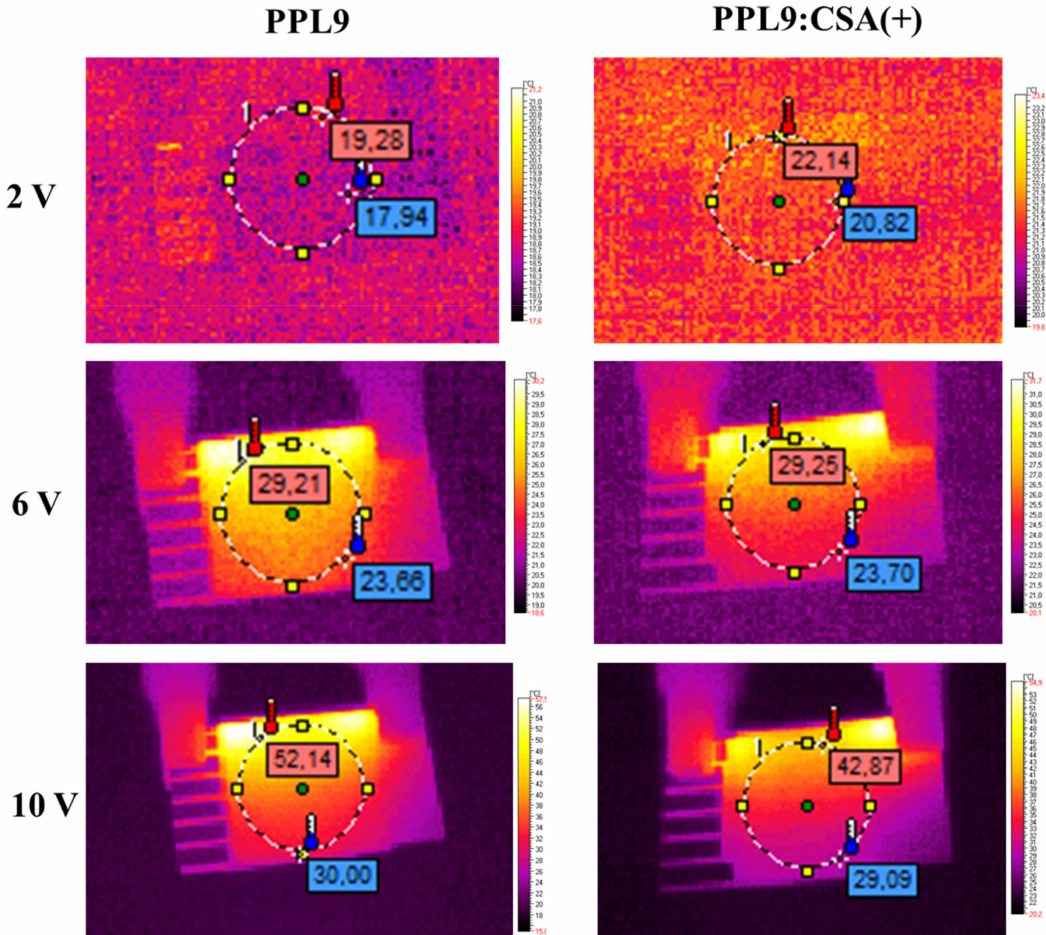
Figure 8. IR images obtained for constructed devices at 2 V, 6 V, and 10